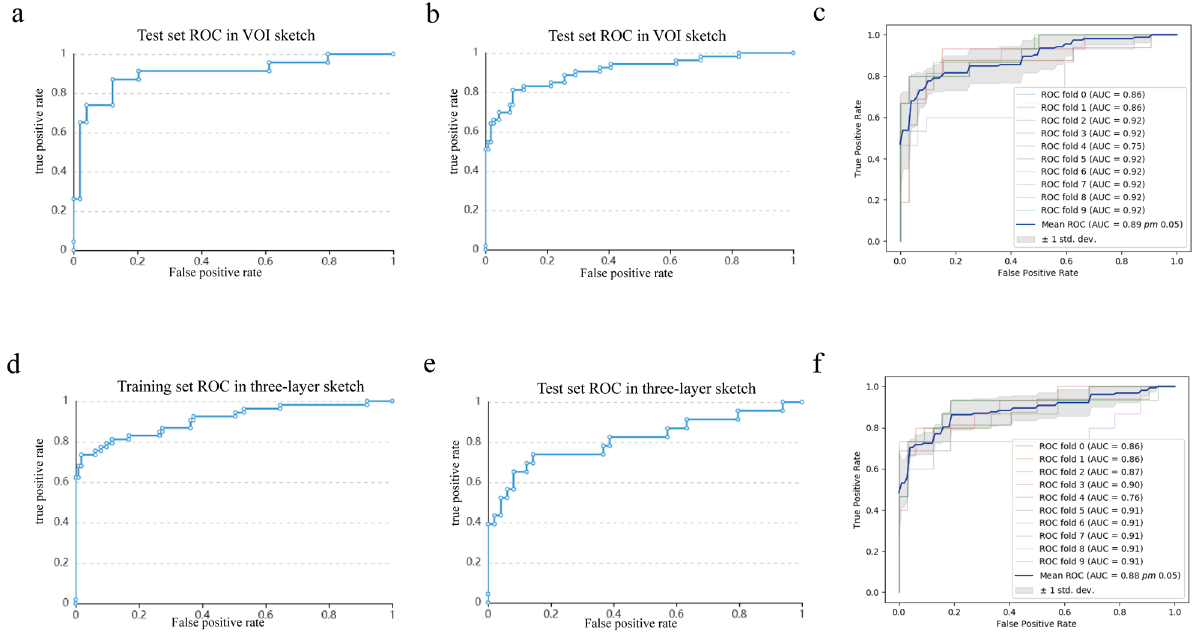
Figure 5. ROC curves for the differential diagnosis of primary and secondary ICH based on an SVM classifier. ROC curves for the VOI sketching method using the training ( a ) and test ( b ) sets. ROC curves for the three- layer sketching method using the training ( c ) and test ( d ) sets. ROC curves of the SVM-based classification with ten-fold cross-validation for the VOI ( e ) and three-layer ( f ) sketching methods.